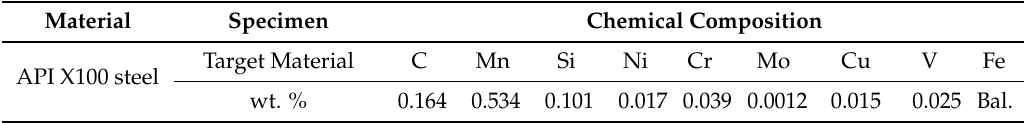
Table 1. Chemical composition of API X100 steel used in the study.